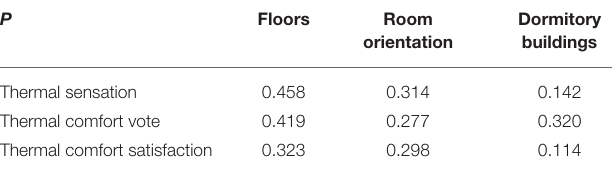
TABLE 5 | One-way ANOVA test of the significance values P . P Floors Room